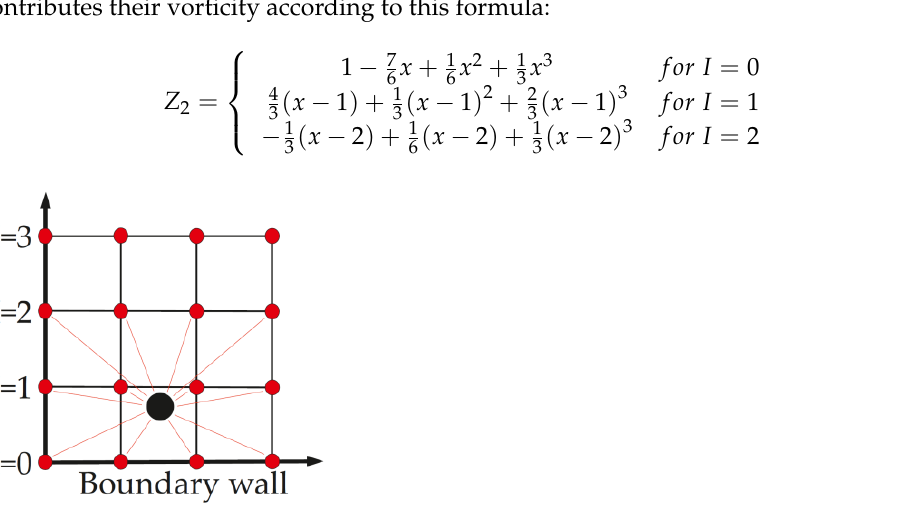
Figure 4. One side